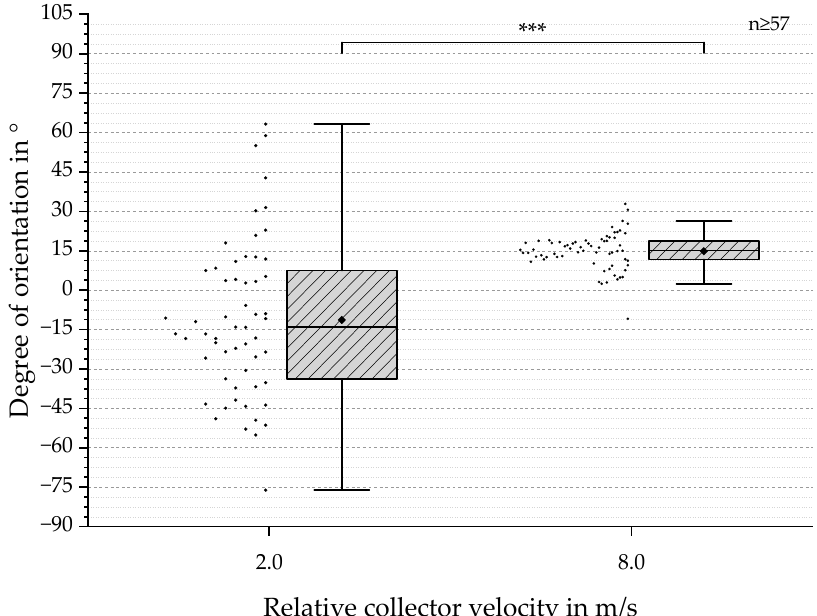
Figure 7. Boxplots with outliers for the degree of orientation in degrees for relative collector velocities of 2.0 and 8.0 m/s. Additionally, individual values are presented as dots on the left side of each boxplot. For 2.0 m/s, the majority of values were located around − 11 ◦ , whereas the values for 8.0 m/s were mainly distributed around 14 ◦ . A wider distribution for 2.0 m/s can be observed and the comparison of both datasets shows a decreased IQR and dispersion for increased relative collector velocity. Due to the QQ Plots indicating normal distribution and the values being independent, a two-samples t-test was conducted. Statistically significant mean differences were found and labeled as follows: *** ( p <